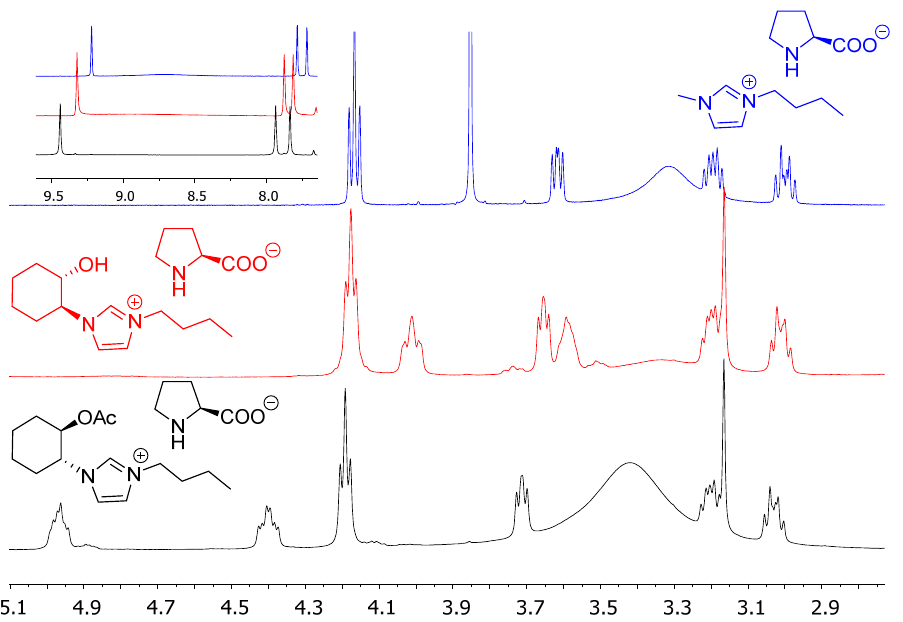
Figure 3. Partial 1 H-NMR in DMSO-d 6 for some imidazolium prolinates derived from L -proline. The room temperature aldol reaction of p -nitrobenzaldehyde with acetone was se-